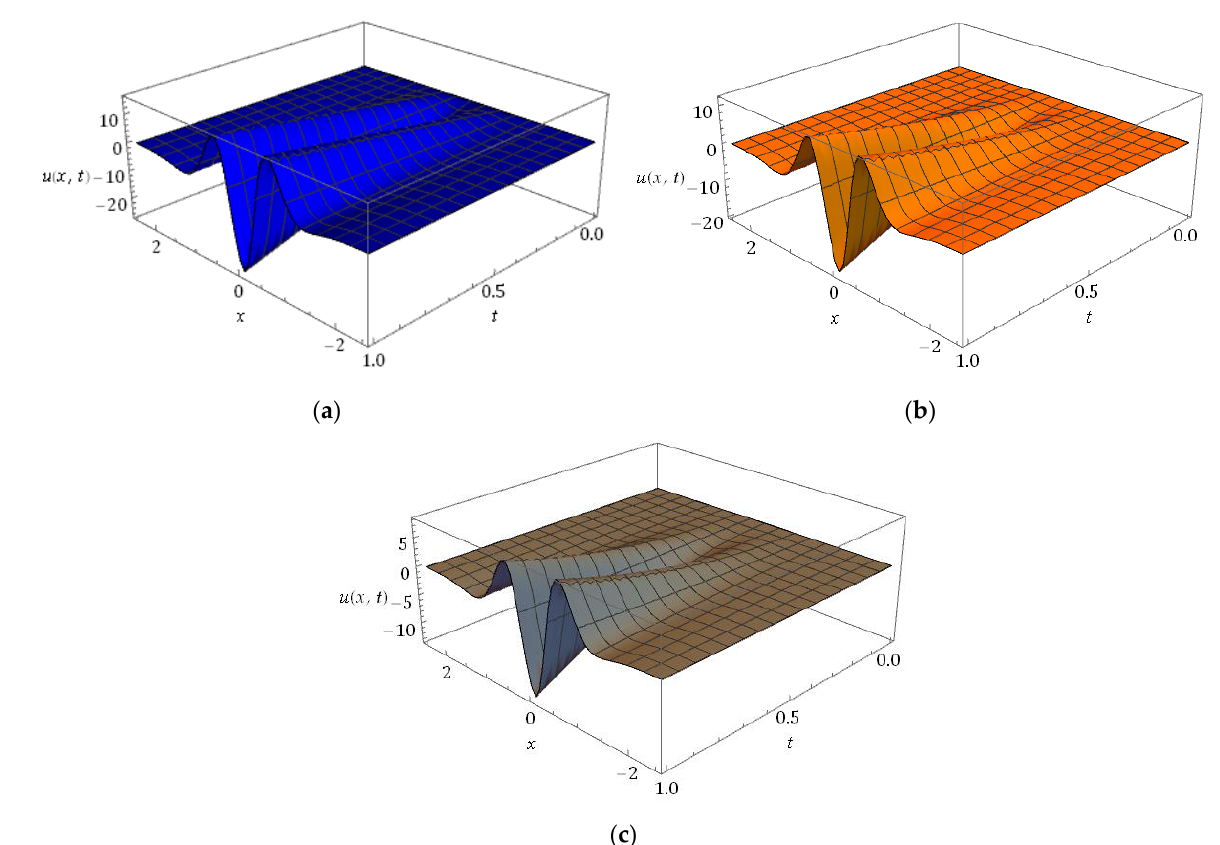
Figure 5. Surfaces of 𝑞 -HATT solution for (𝒂) 𝛼 = 0.50 , (𝒃) 𝛼 = 0.75 and (𝒄) 𝛼 = 1 at 𝑛 = 1, ℏ = −1, 𝛽 = 1, 𝑐 = −1, 𝜅 1 = 1 and 𝜌 = 0.001 for Case II.